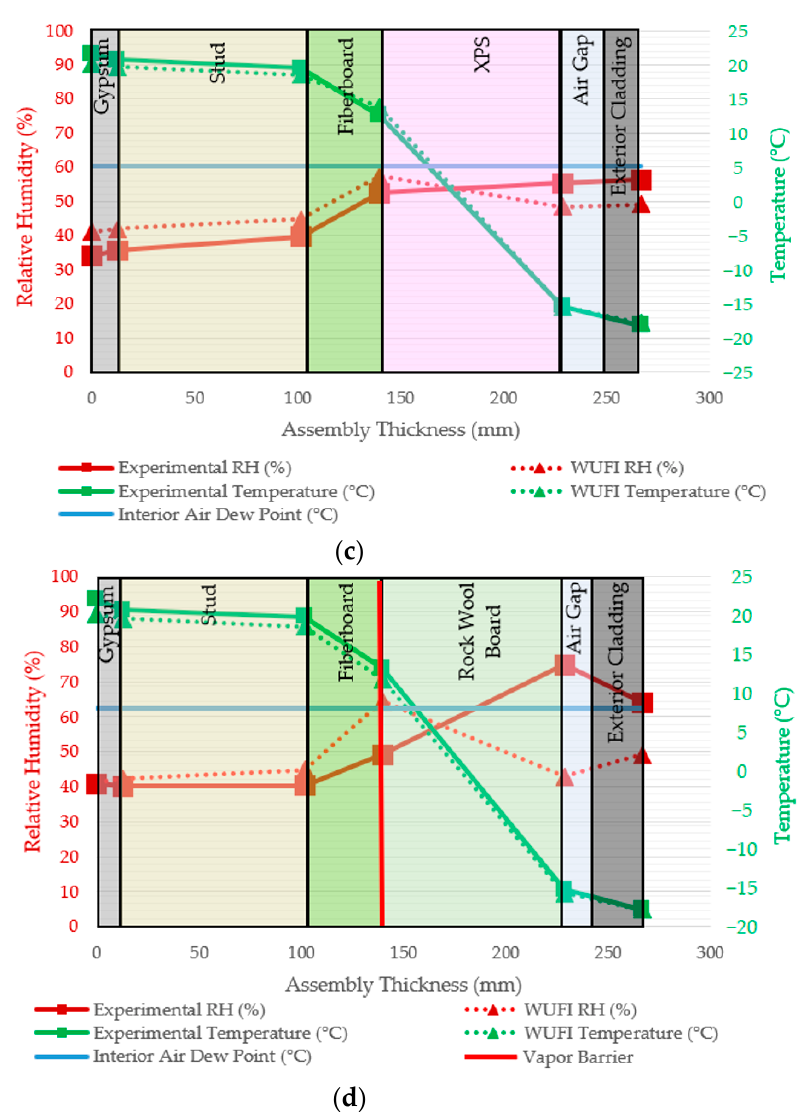
Figure 5. The temperature, calculated experimental interior air dew point and RH profiles for the tested assemblies: ( a ) A140OX38; ( b ) A89X102; ( c ) A89F38X89; ( d ) A89F38W102.